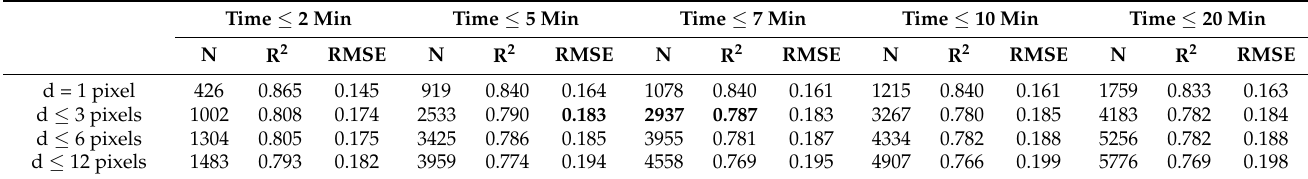
Table 1. Sun photometer ground verification results for AHI (Advanced Himawari Imager) AOD with different combinations of time and space screening; the bold font in the table is the spatio-temporal window we selected.